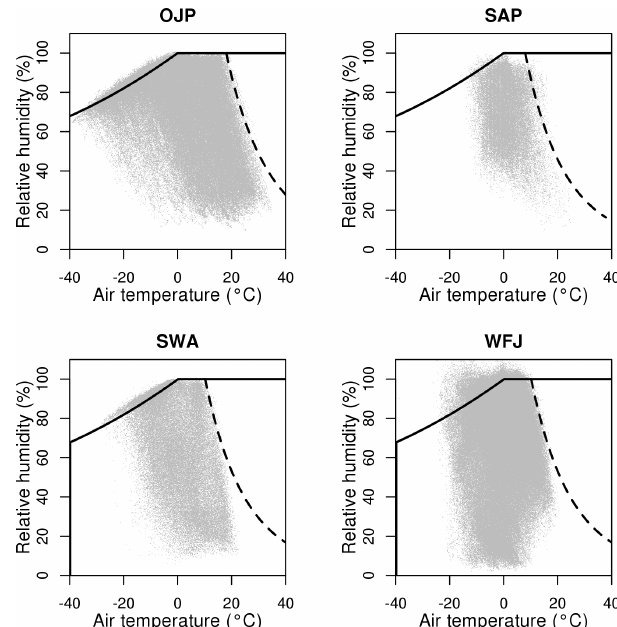
Figure 4. Fraction of precipitation falling as snow at different tem- peratures, as imposed on the in situ data and fitted to the GSWP3